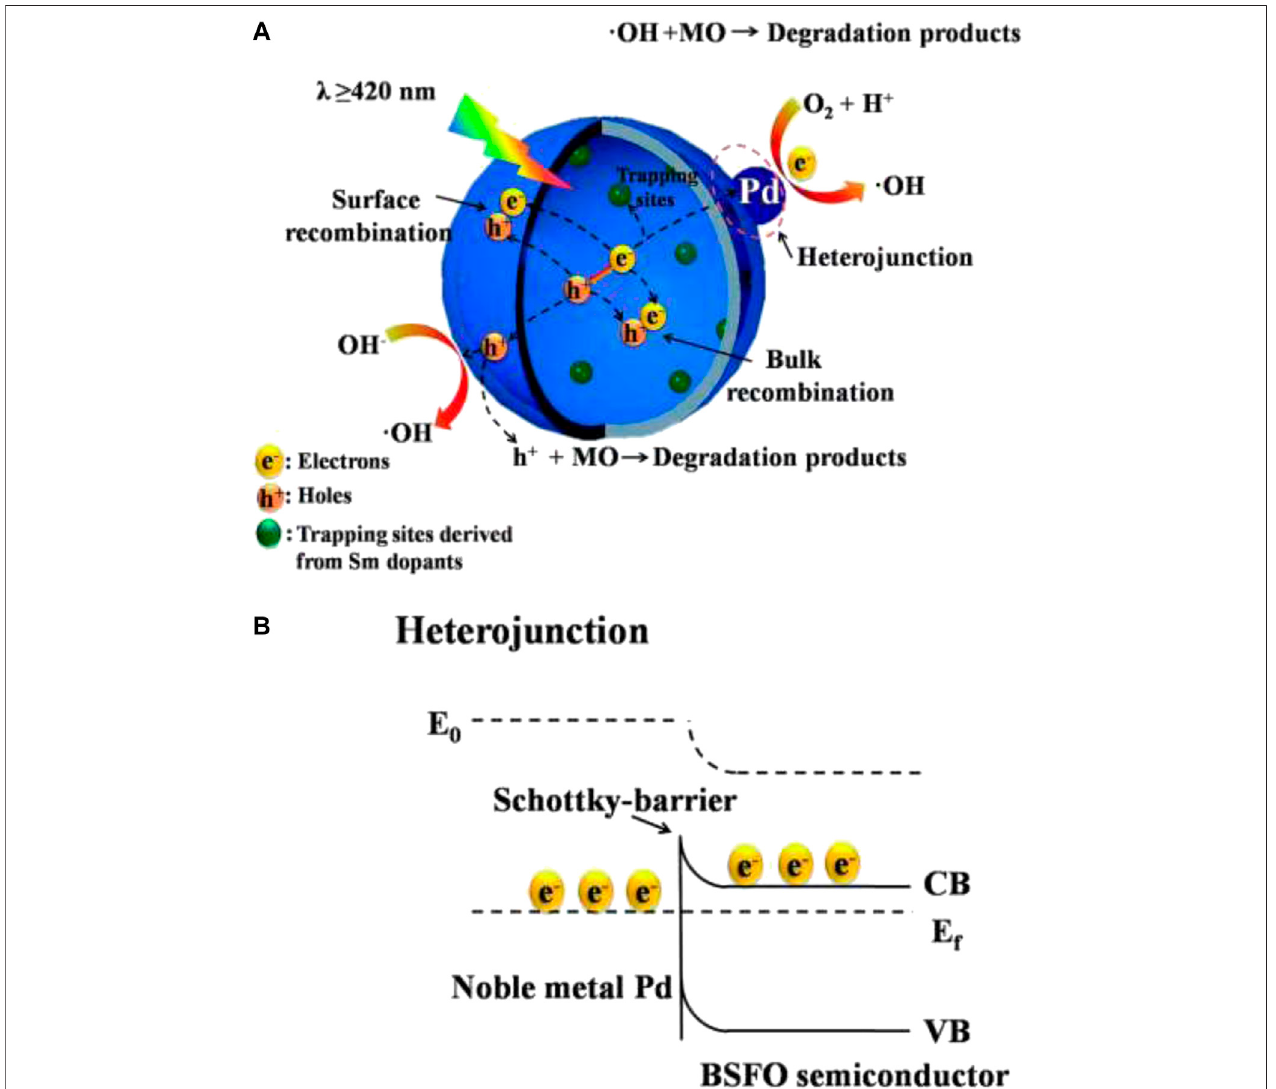
FIGURE 9 | (A) Schematic diagram for the proposed visible light photocatalytic mechanism of Pd/BSFO samples and (B) schematic illustration of Schottky barrier formed at the interface between Pd and BSFO (reproduced with permission (Wang S. et al., (2016).